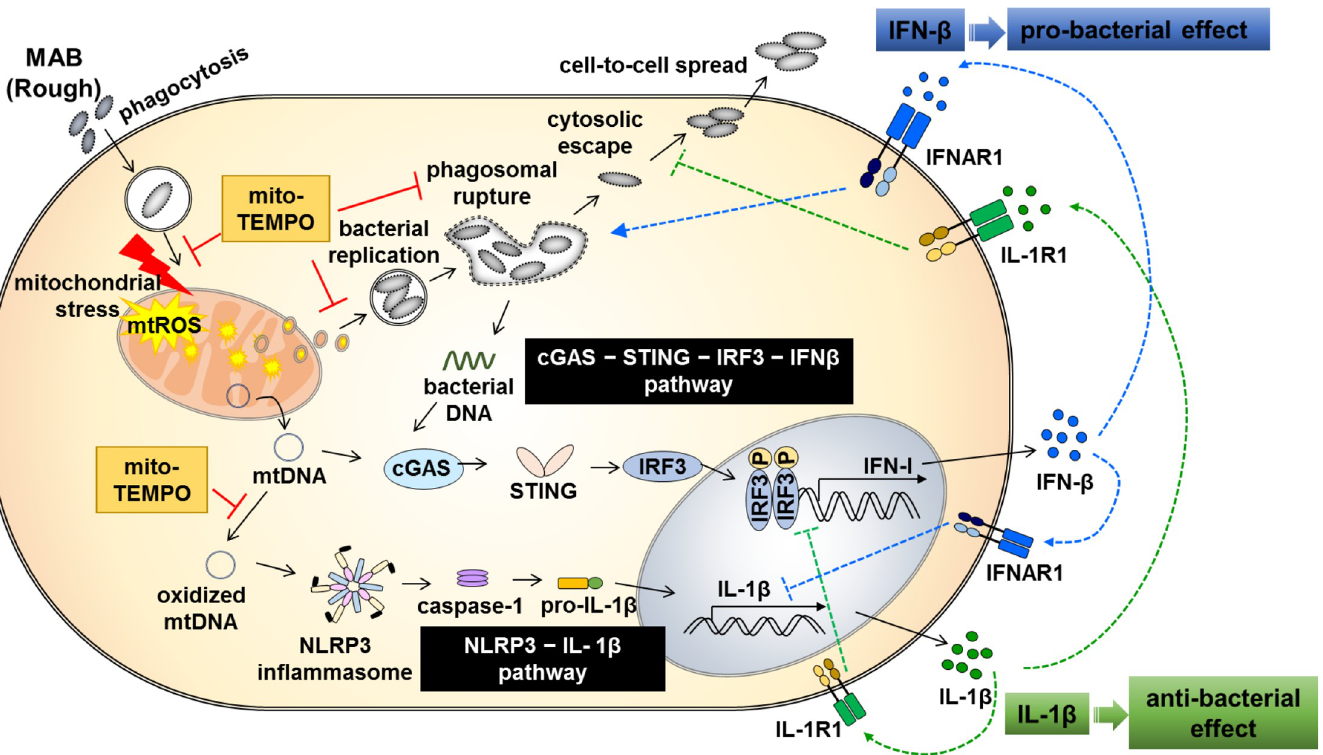
Fig 8. Schematic diagram showing mitochondrial oxidative stress induced by MAB-R infection of murine macrophages. MAB-R enters macrophages by phagocytosis and leads to mitochondrial oxidative stress. Our results suggest that MAB-R infection elicits both the i) cGAS − STING − IRF3 − IFN- β and ii) NLRP3 inflammasome-IL-1 β pathways in murine macrophages: i) Excess formation of mtROS leads to phagosomal rupture-mediated bacterial escape into the cytosol. Cytosolic mitochondrial and mycobacterial DNA induce IFN-I production via the cGAS − STING − IRF3 pathway. ii) Additionally, oxidized mtDNA released into the cytosol leads to activation of the NLRP3 inflammasome. However, inhibition of mtROS by treatment with mito-TEMPO or CsA decreases the levels of mtROS and also leads to decreased IFN-I and IL-1 β production. In addition, inhibition of mtROS leads to a reduction in MAB-R replication in phagosomes and inhibition of phagosomal rupture, which ultimately reduces bacterial survival in infected murine macrophages. These two pathways induce opposite results for host defence against MAB-R infection. IL-1 β is considered to have antibacterial effects, while IFN-I is recognized to be highly detrimental to bacterial